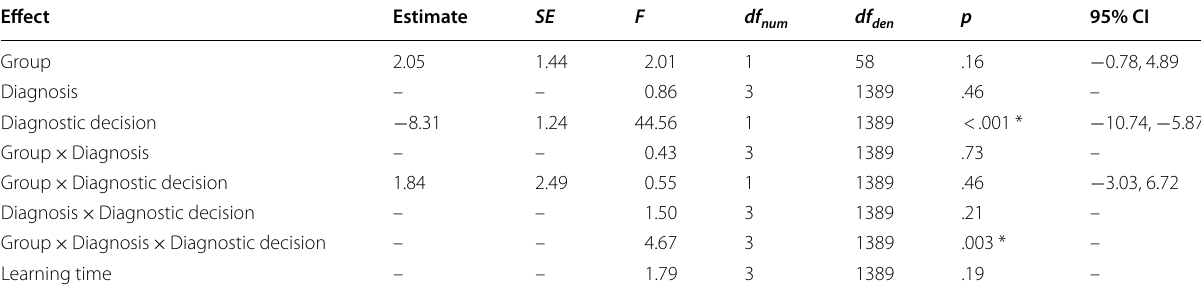
Table 3 Model parameter estimates from Experiment